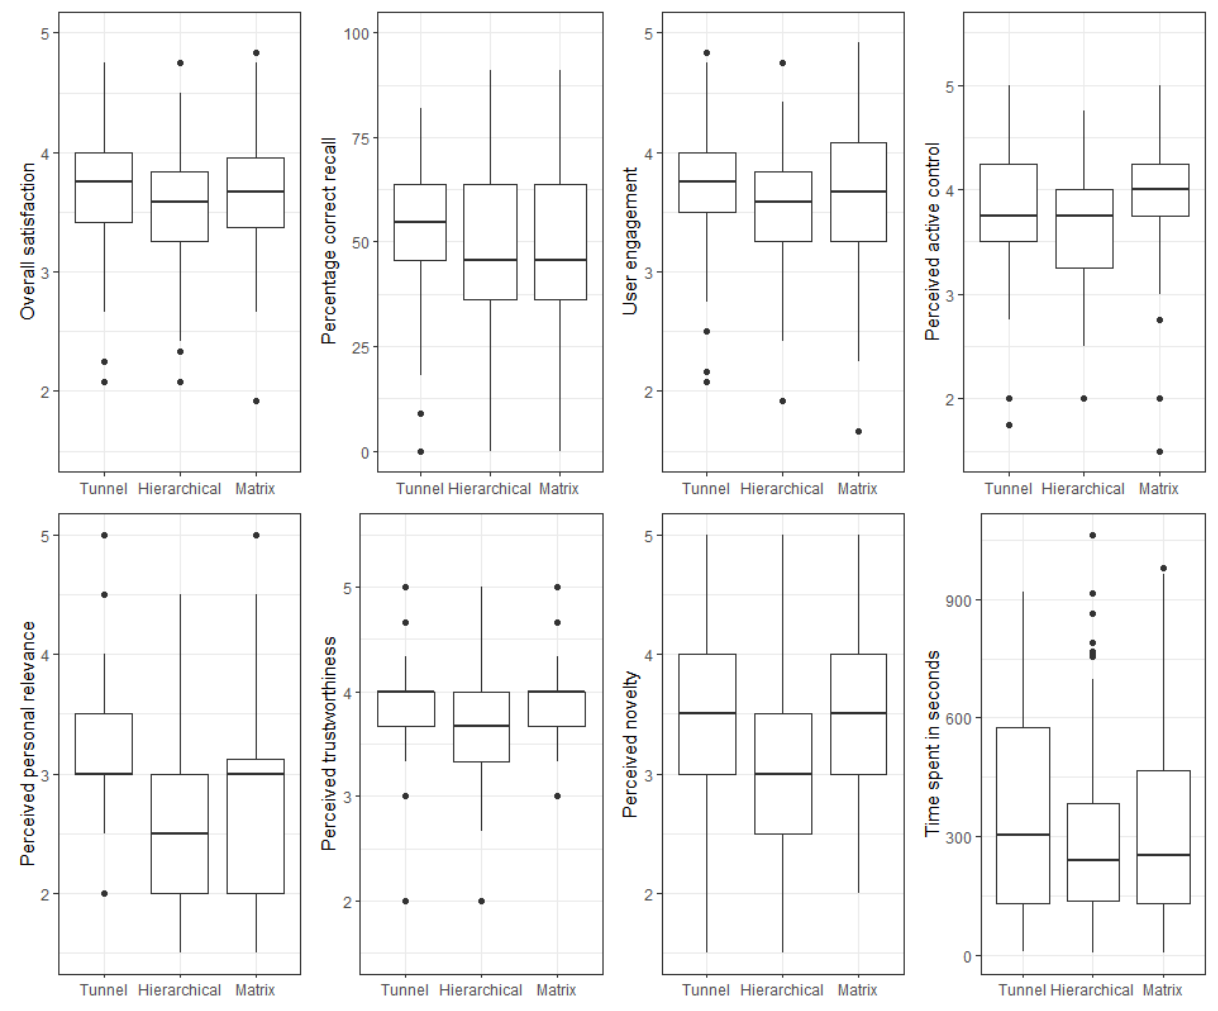
Figure 4. Main effects of information